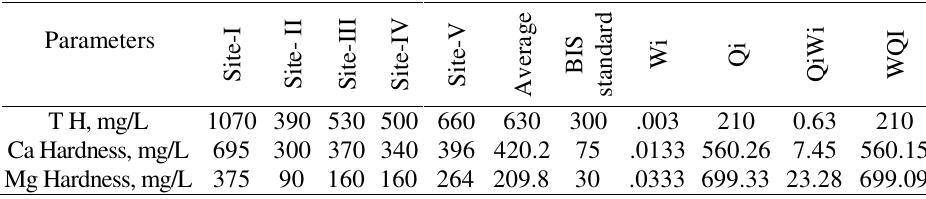
Table 6. WQI of Todaraisingh area of